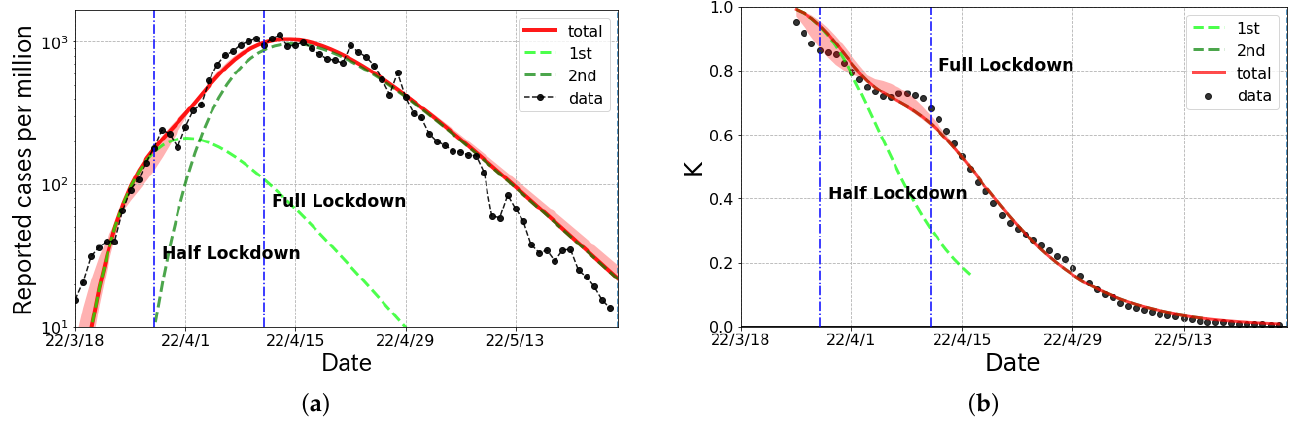
Figure 3. The logarithmic plot of the epicurve for the Omicron surge in COVID-19 in Shanghai from March to June 2022. ( a ) The reported cases per million and fitted results (solid curve). The fit was performed with two partial waves denoted by dashed lines. ( b ) The observed data and fitted results of the K-value. The red bands stand for the systematic errors in the choice of the fitted range of the first and second partial wave.